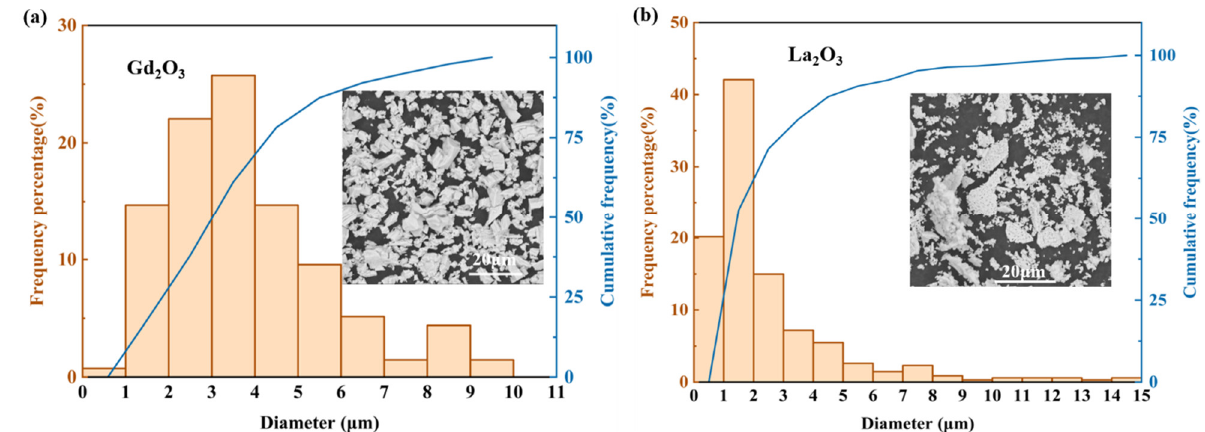
Figure 1. Size distribution of oxide particles, ( a ) Gd 2 O 3 , ( b ) La 2 O. Insets show the SEM images of the oxide particles.